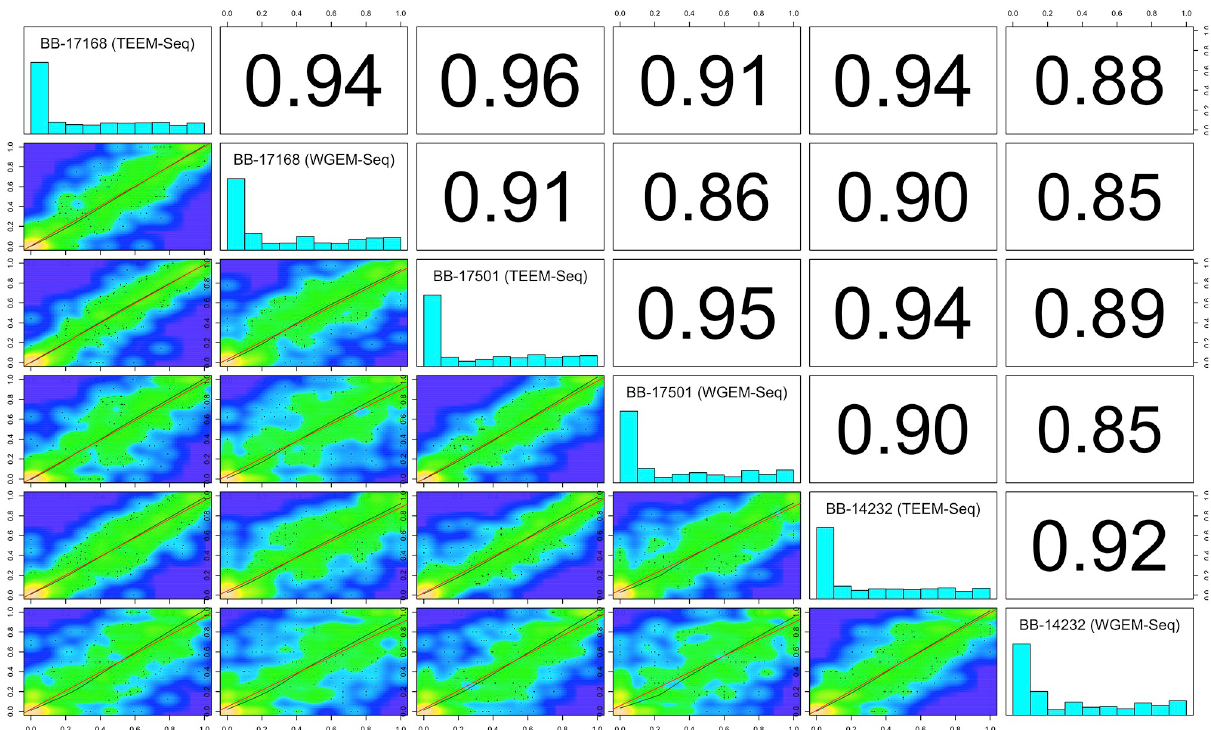
Fig 3. Putative promoter target region CpG site-level percent DNA methylation distribution histograms for each sample library and scatterplots with Pearson correlation coefficients between target-enriched enzymatic methyl sequencing (TEEM-Seq) and whole-genome enzymatic methyl sequencing (WGEM-Seq) libraries from the same individual superb starlings. CpG sites shared between TEEM-Seq and WGEM-Seq libraries at 5x coverage or above were used for comparisons across all libraries (816 CpG sites shared) with the getCorrelation function in methylKit for superb starling individuals BB-17168, BB-17501, and BB-14232. Note that S4 Fig shows the same within-individual comparisons, only with higher numbers of shared CpG sites because of within-sample comparisons only. Blue regions of the scatterplots are uncorrelated, yellow regions are highly correlated, and green regions are variably correlated. The green lines represents lowess polynomial regression fits, whereas the red lines represent linear regression fits. Across samples, the correlation coefficients for TEEM-Seq versus TEEM-Seq comparisons are slightly higher (0.95 mean) than for TEEM-Seq versus WGEM-Seq comparisons (0.94 mean), which is not surprising because WGEM-Seq libraries are much lower in mean target region coverage and therefore site-level CpG percent methylation scores could be less reliable; in any case the similarity in correlation coefficient means suggests that TEEM-Seq does not flatten differences in methylation calls as compared with WGEM-Seq. As expected within each sample, the TEEM-Seq versus WGEM-Seq library correlation coefficients are higher for each sample comparison than for WGEM-Seq versus WGEM-Seq compared across samples (see also S6 Fig for WGEM-Seq versus WGEM-Seq complete